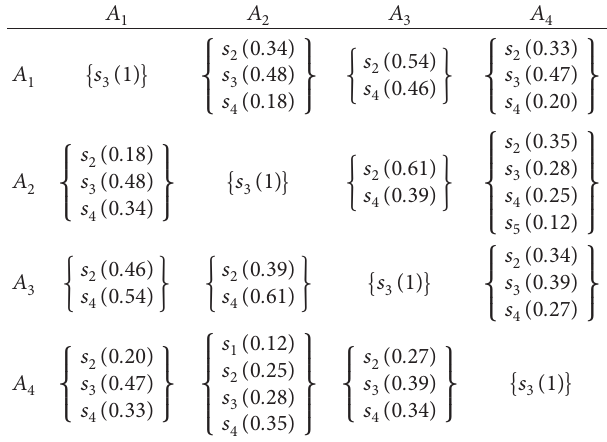
the normalized matrix shown as equation (41) will be obtained based on the increased matrix.